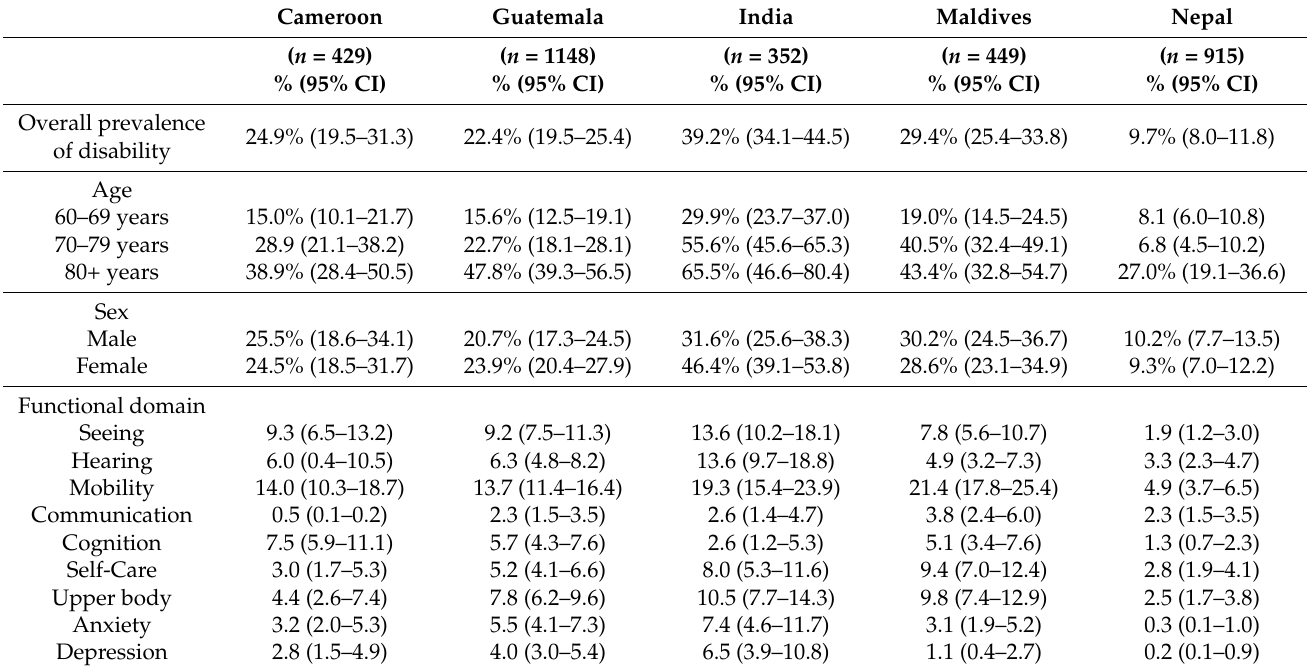
Table 1. Prevalence of disability overall and by age, sex and functional domain among older populations in Cameroon, Guatemala, India, Nepal and the